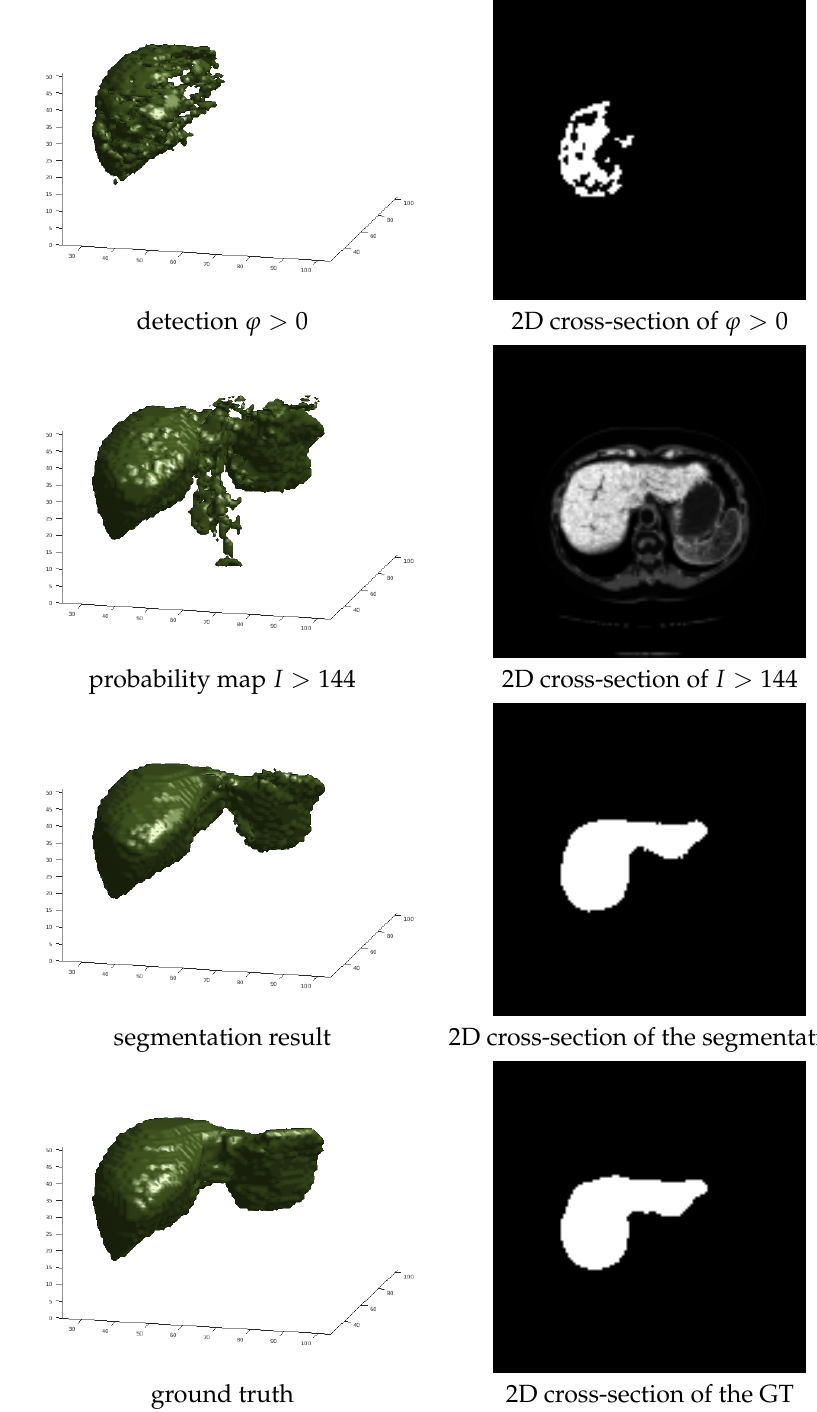
Figure 7. Detection, probability map, segmentation result of the 3D CVNN-UNet and ground truth of the liver of a CT scan from the BTCV dataset. The left column is the 3D view, the right column is the axial view of the 40-th